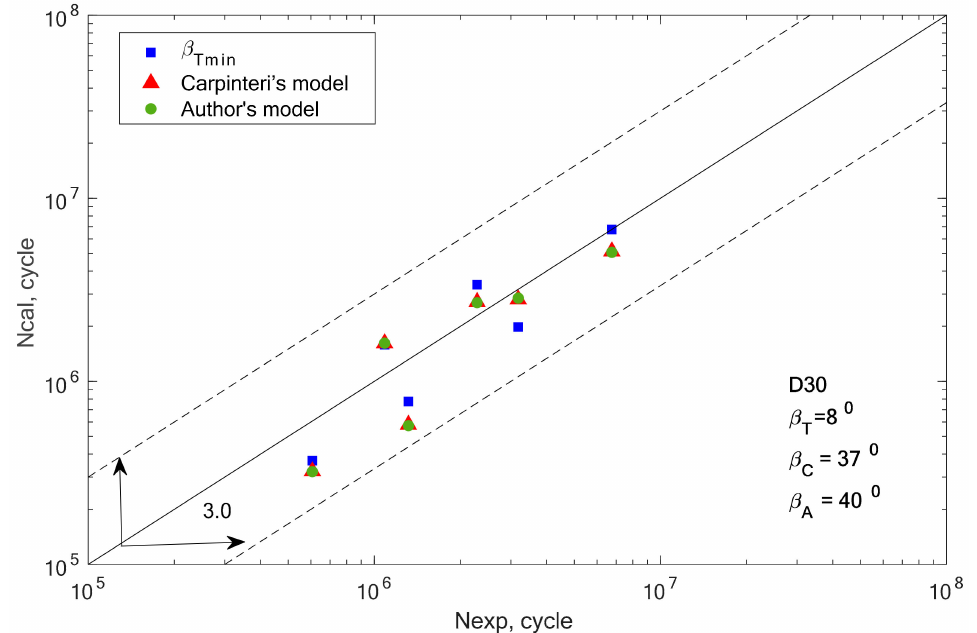
Figure 13. Comparison of the obtained design and experimental life for aluminium alloy D30 for the cyclic bending–torsion